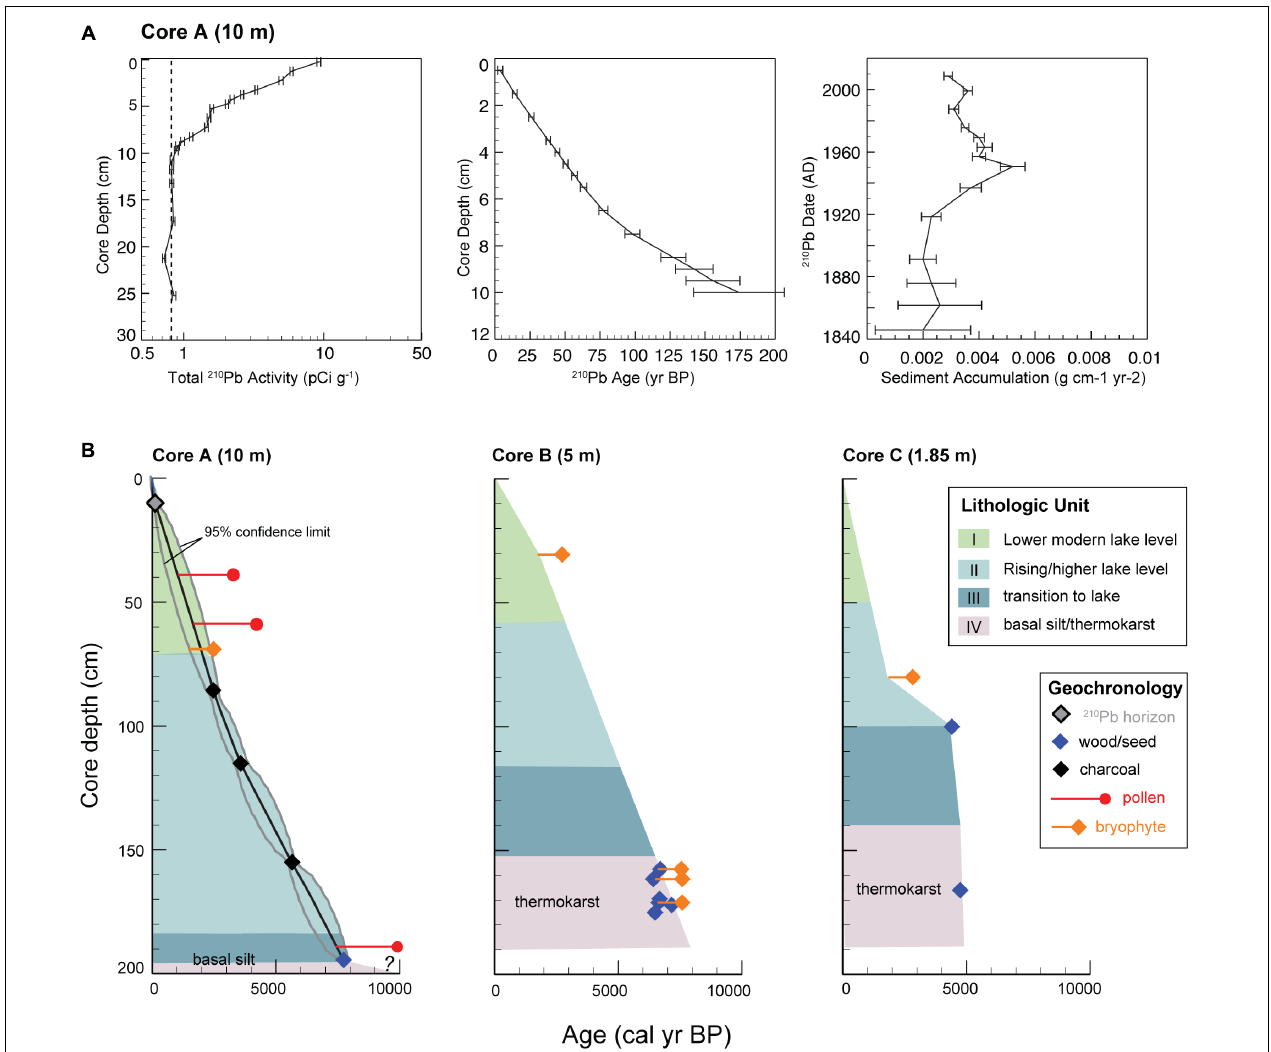
FIGURE 5 | (A) Sediment core A 210 Pb activity, CRS ages, and sediment accumulation rates with error ranges. (B) Core A (10-m water depth) Bacon age model (mean is black line and gray lines indicated 95% confidence limits; Supplementary Figure 3 ) shown with lithologic units and all calibrated radiocarbon ages (cal yr BP) for core B (5-m water depth) and core C (1.85 m water depth); charcoal (black), pollen (red) and aquatic bryophytes (orange). The radiocarbon age symbols are larger than calibrated 1-sigma age errors and tails on the pollen and bryophyte symbols reflect age offsets ( Table 3 ).